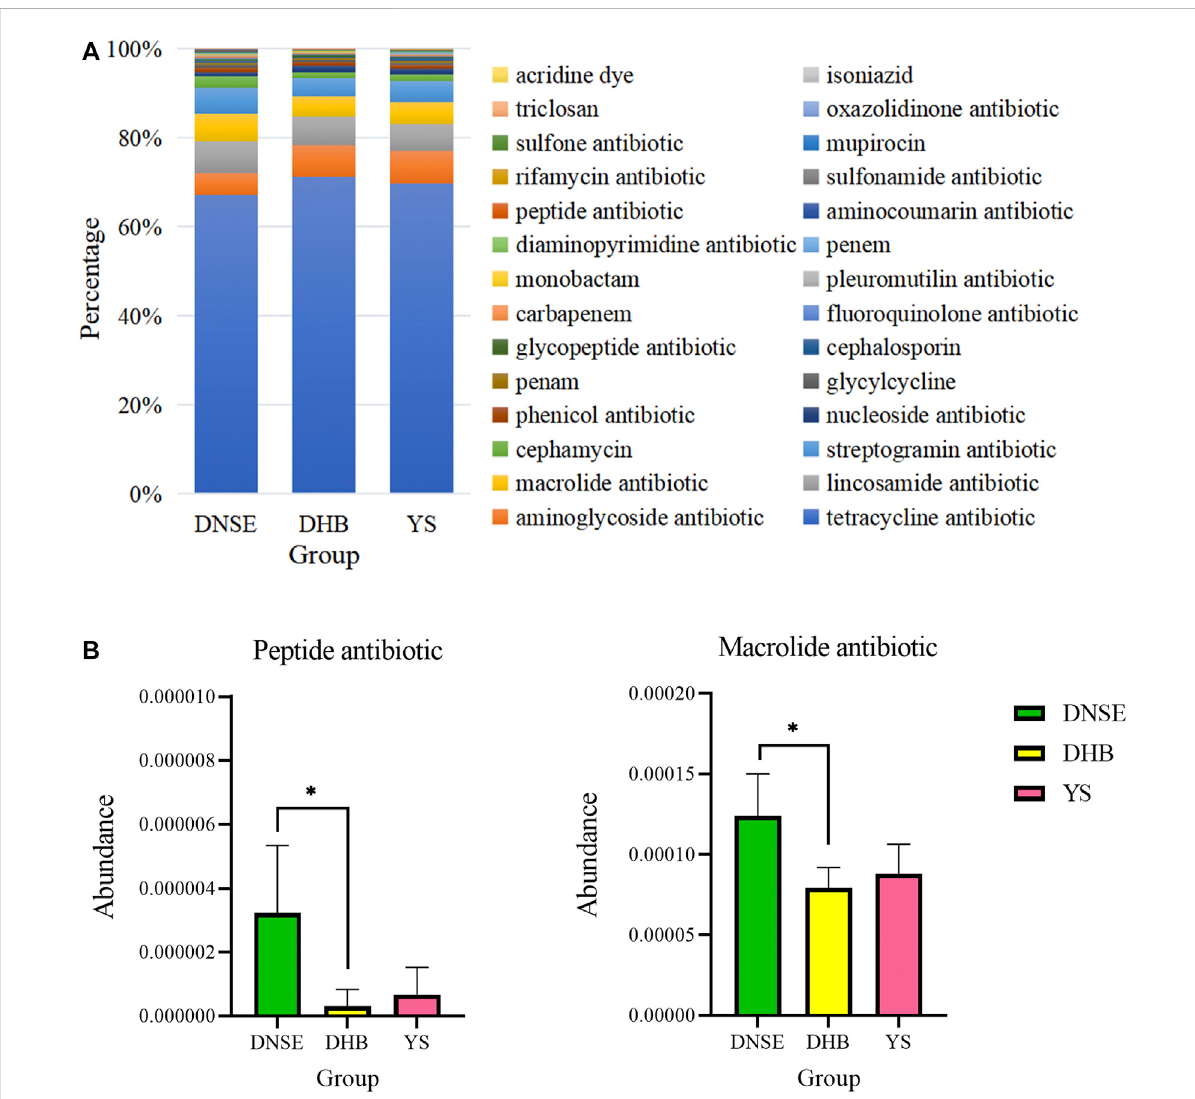
FIGURE 7 (A) ProportionsofARGtypes. (B) ARGtypeswithsigni fi cantdifferencesamongthreepigbreeds.ErrorbarsrepresentstheSDofthreereplicates, * p <